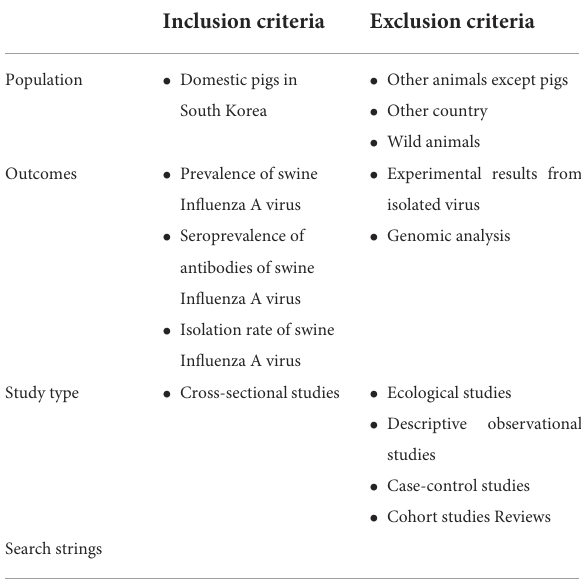
TABLE 1 Eligibility criteria and search strings for investigating the prevalence or the seroprevalence of swine influenza A virus (swIAV) for domestic pigs in South